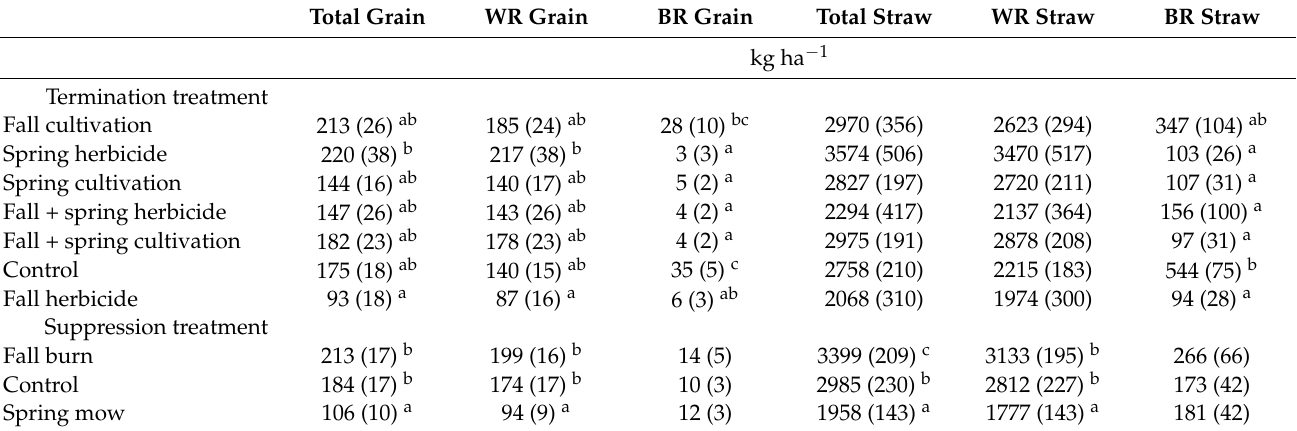
Table 3. Mean ( ± SE, n = 4) of grain and straw yields by termination treatments (averaged over suppression treatments) and suppression treatments (averaged over termination treatments) in 2019. Means sharing a letter within a column are similar ( p < 0.05).